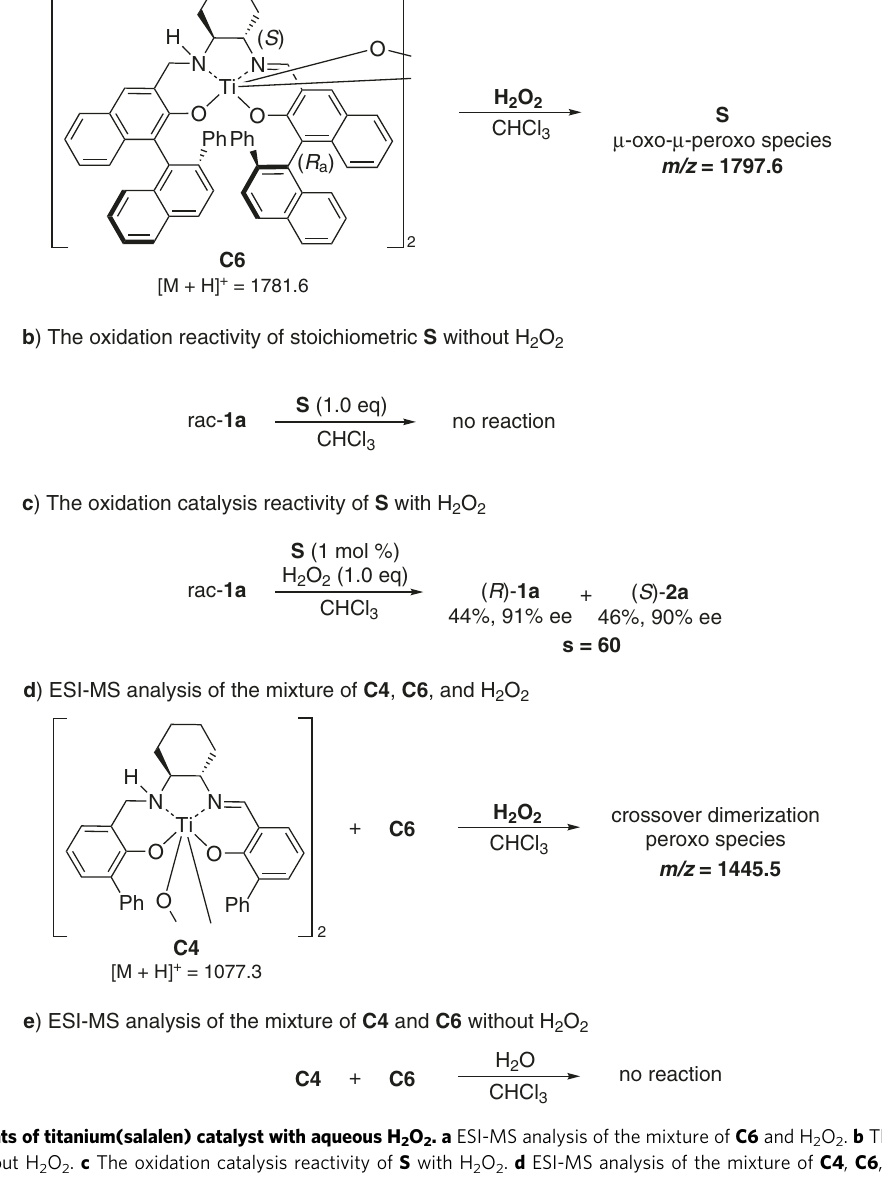
Fig. 7 Control experiments of titanium(salalen) catalyst with aqueous H 2 O 2 . a ESI-MS analysis of the mixture of C6 and H 2 O 2 . b The oxidation reactivity of stoichiometric S without H 2 O 2 . c The oxidation catalysis reactivity of S with H 2 O 2 . d ESI-MS analysis of the mixture of C4 , C6 , and H 2 O 2 . e ESI-MS analysis of the mixture of C4 and C6 without H 2 O 2